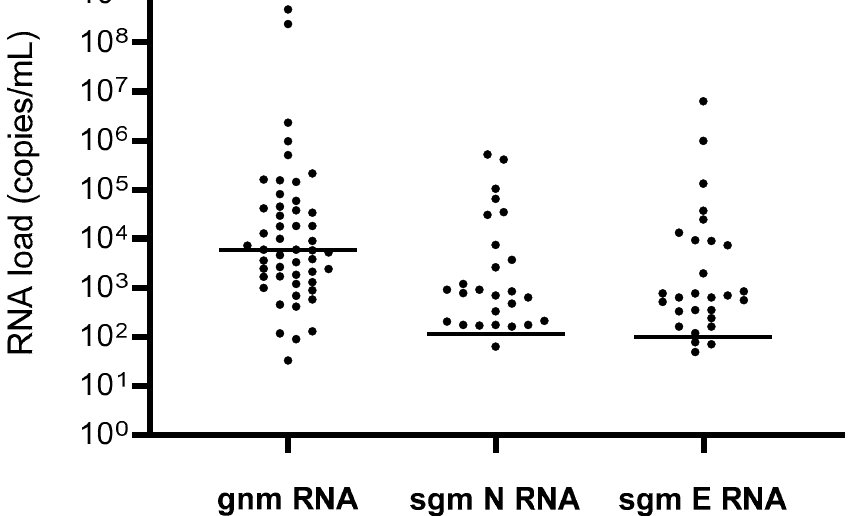
Figure 2. SARS ‐ CoV ‐ 2 genomic and subgenomic RNA load in antigenic false ‐ negative samples. Gnm = genomic; sgm = subgenomic; E = envelope; N = nucleocapsid.